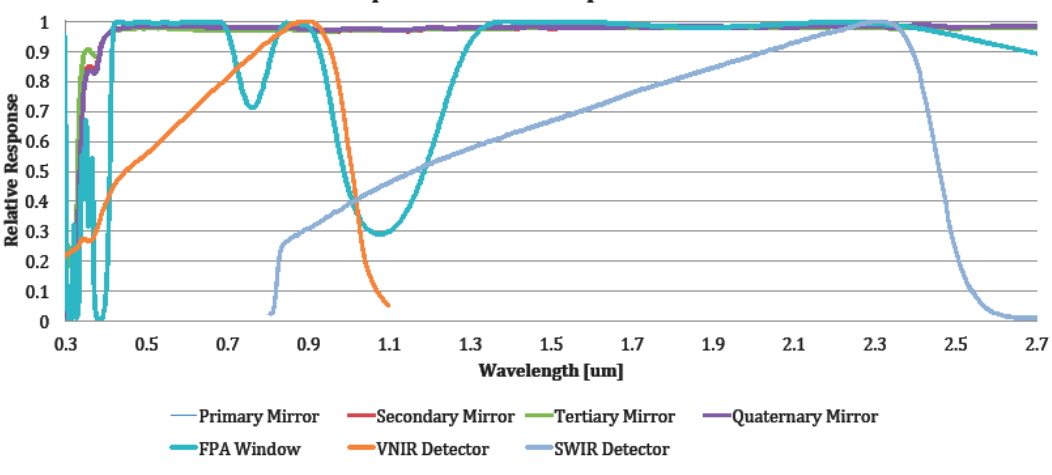
Figure 2. Relative responses of OLI optical path components over entire spectral range of the instrument, including some out-of-band response. Detector relative response is radiance (power)